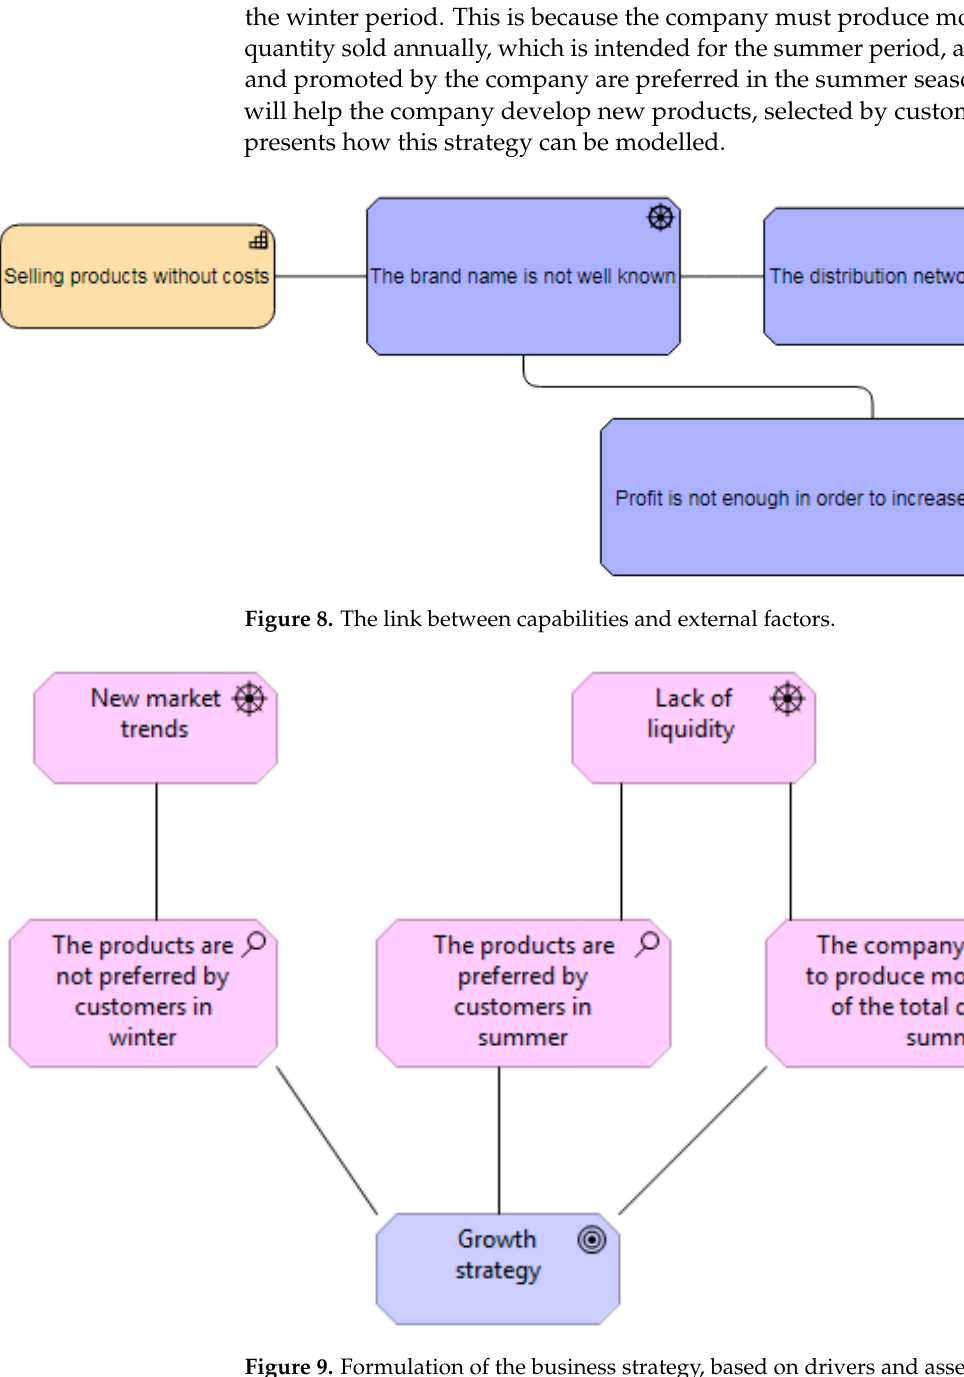
Figure 9. Formulation of the business strategy, based on drivers and assessments. Another significant weakness is the existence of marketing by competing companies, as they have existed in the field for several years and, thus, have strengthened their net- work and brand name towards the consumer. This weakness is addressed through the